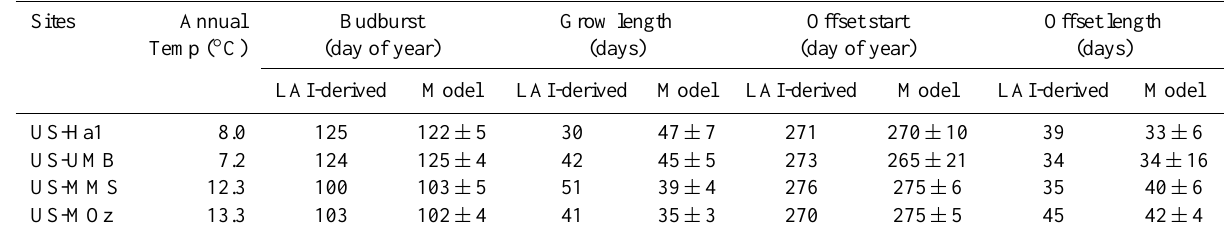
Table 3. Phenological and climatological parameters for four deciduous forest sites predicted by segmented regressions (Fig. S1) and the selected phenology models (S9 + A4, refer to Table 5).